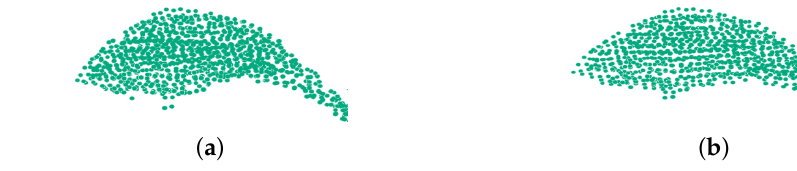
Figure 6. Comparison the original point cloud and moving least squares (MLS) processed point cloud. ( a ) Picking a leaf’s point cloud from the whole point cloud. ( b ) Smoothing these point clouds with MLS